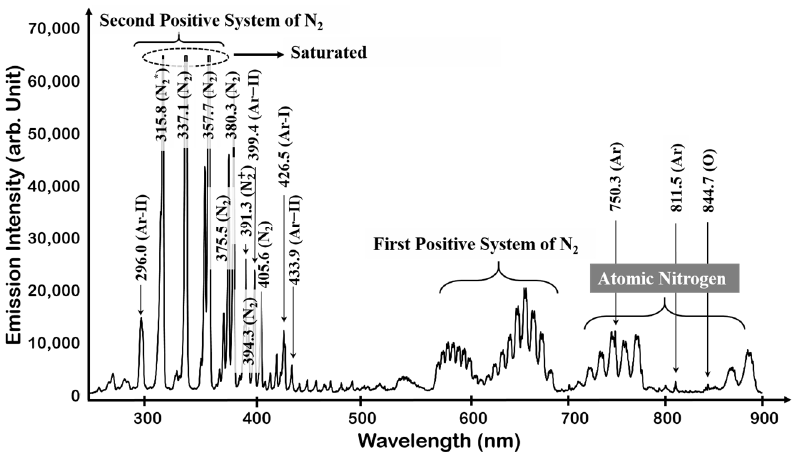
Figure 3. OES spectrum of N 2 plasm.